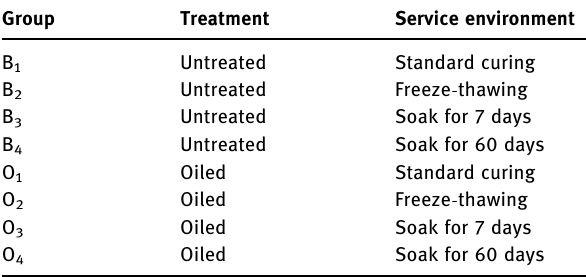
Table 5: Experiment scheme